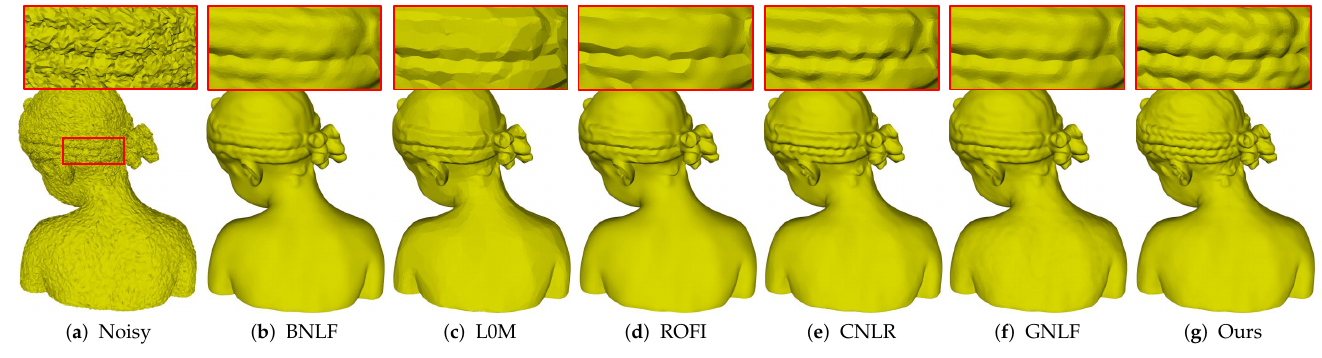
Figure 5. Denoising results of Girl model.